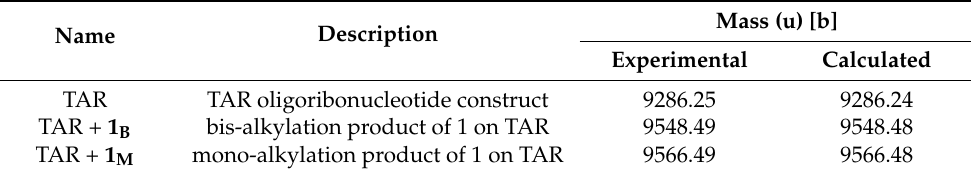
Figure 4. Representative electrospray-ionization mass spectrometry (ESI-MS) spectra of reaction mixtures obtained by incubating TAR (1 µ M) with increasing B-CeP 1 ( A :0, B :1, C :10, D :50 µ M) at 37 °C for 2 h in a BPE buffer (pH 7.4). The spectra B – D show the concentration-dependent reactions induced by B-CeP 1 on TAR. Greater stoichiometries corresponding to combinations of mono- and bi-functional adducts, were detected and indicated in orange in the figure. The spectra were recorded in 150 mM ammonium acetate. Lower intensity signals near free/adducted species consist of typical sodium and ammonium adducts. Only region containing the 5-charge state is shown for the sake of clarity. Table 1. Name, description, experimental and calculated masses for the species detected in Figure 4B. [a]